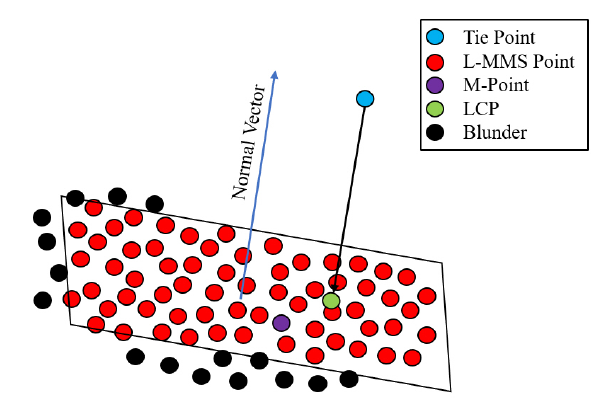
Figure 2. Representation of the tie point and its projection on the